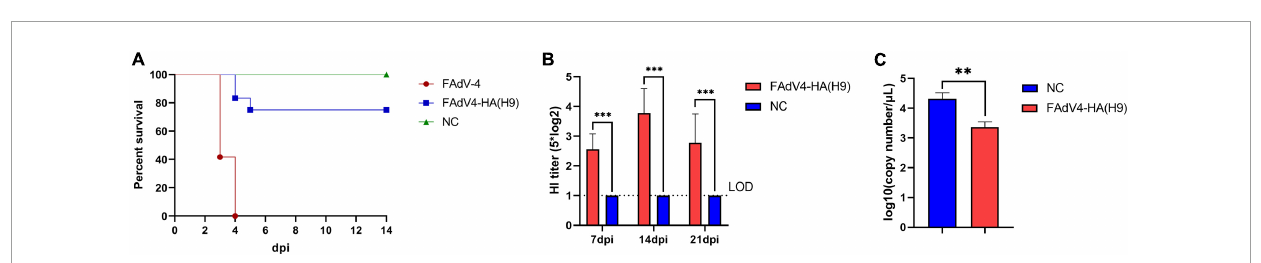
FIGURE5 Chicken infection study with the recombinant virus FAdV4-HA(H9). Two-week-old SPF chickens were inoculated intramuscularly with the recombinant virus FAdV4-HA(H9) and wild-type FAdV-4, and monitored for 14 days. At 21 dpi, all the chickens survived were challenged with XZ491 and the oropharynx were collected at 5 dpc for viral loads. (A) Survival rates of SPF chickens after viral inoculation. (B) The HI titers against H9N2 AIV induced by the recombinant virus FAdV4-HA(H9) at the indicated time points. (C) Viral loads in the oropharynx from the chickens of group I [FAdV4-HA(H9)] and group III (NC) after challenge. Statistical analysis in this experiment was performed with a Student’s t -test using GraphPad Prism 8 software. *** p <